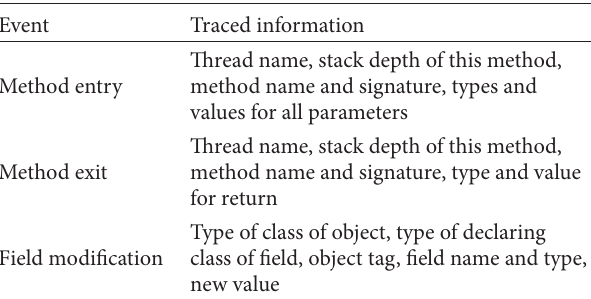
Table 1: Types of events and corresponding information traced by the tracing